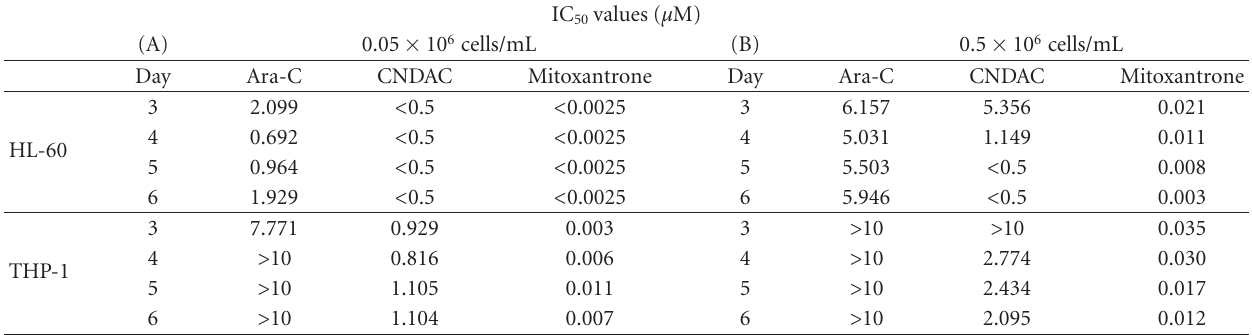
Table 2: IC 50 values of Ara-C, CNDAC, and mitoxantrone for HL-60 and THP-1 cell lines plated at (A) 0.05 × 10 6 cells/mL and (B) 0.5 × 10 6